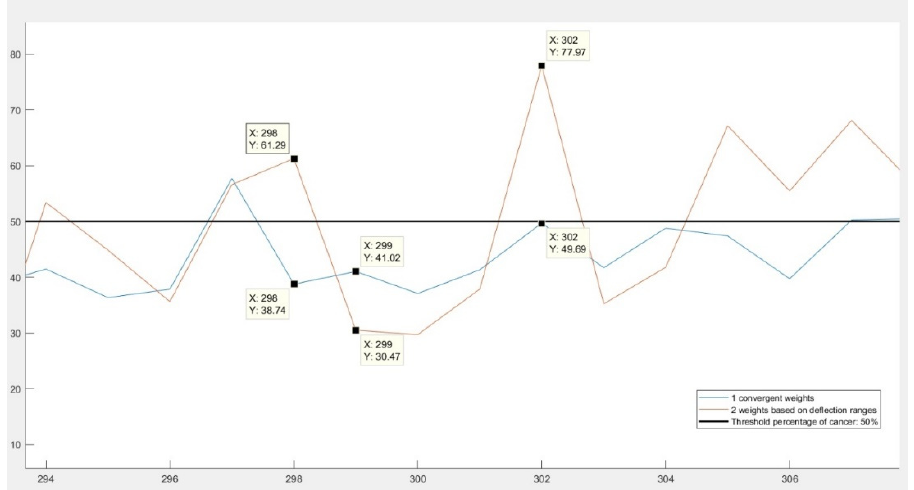
Figure 2. Comparison of the results obtained using convergent weights and weights based on deflection ranges.